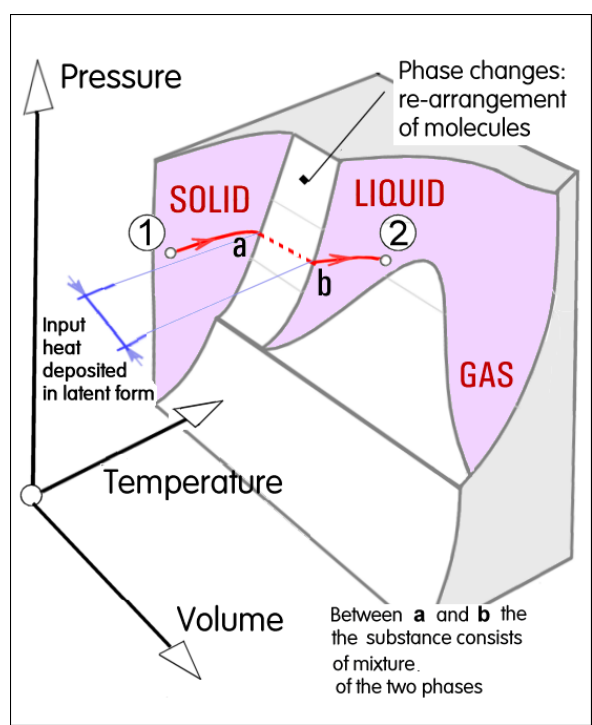
Fig. 2. When a solid substance is heated, the limit a is reached at which all additional thermal input is used to liberate the molecules into free motion in liquid phase. Temperature is not increased until all molecules undergo the phase change to b . The diagram applies to paraffins the volume of which increases during melting (solid paraffin body does not float on the liquid phase surface and sinks to the bottom).